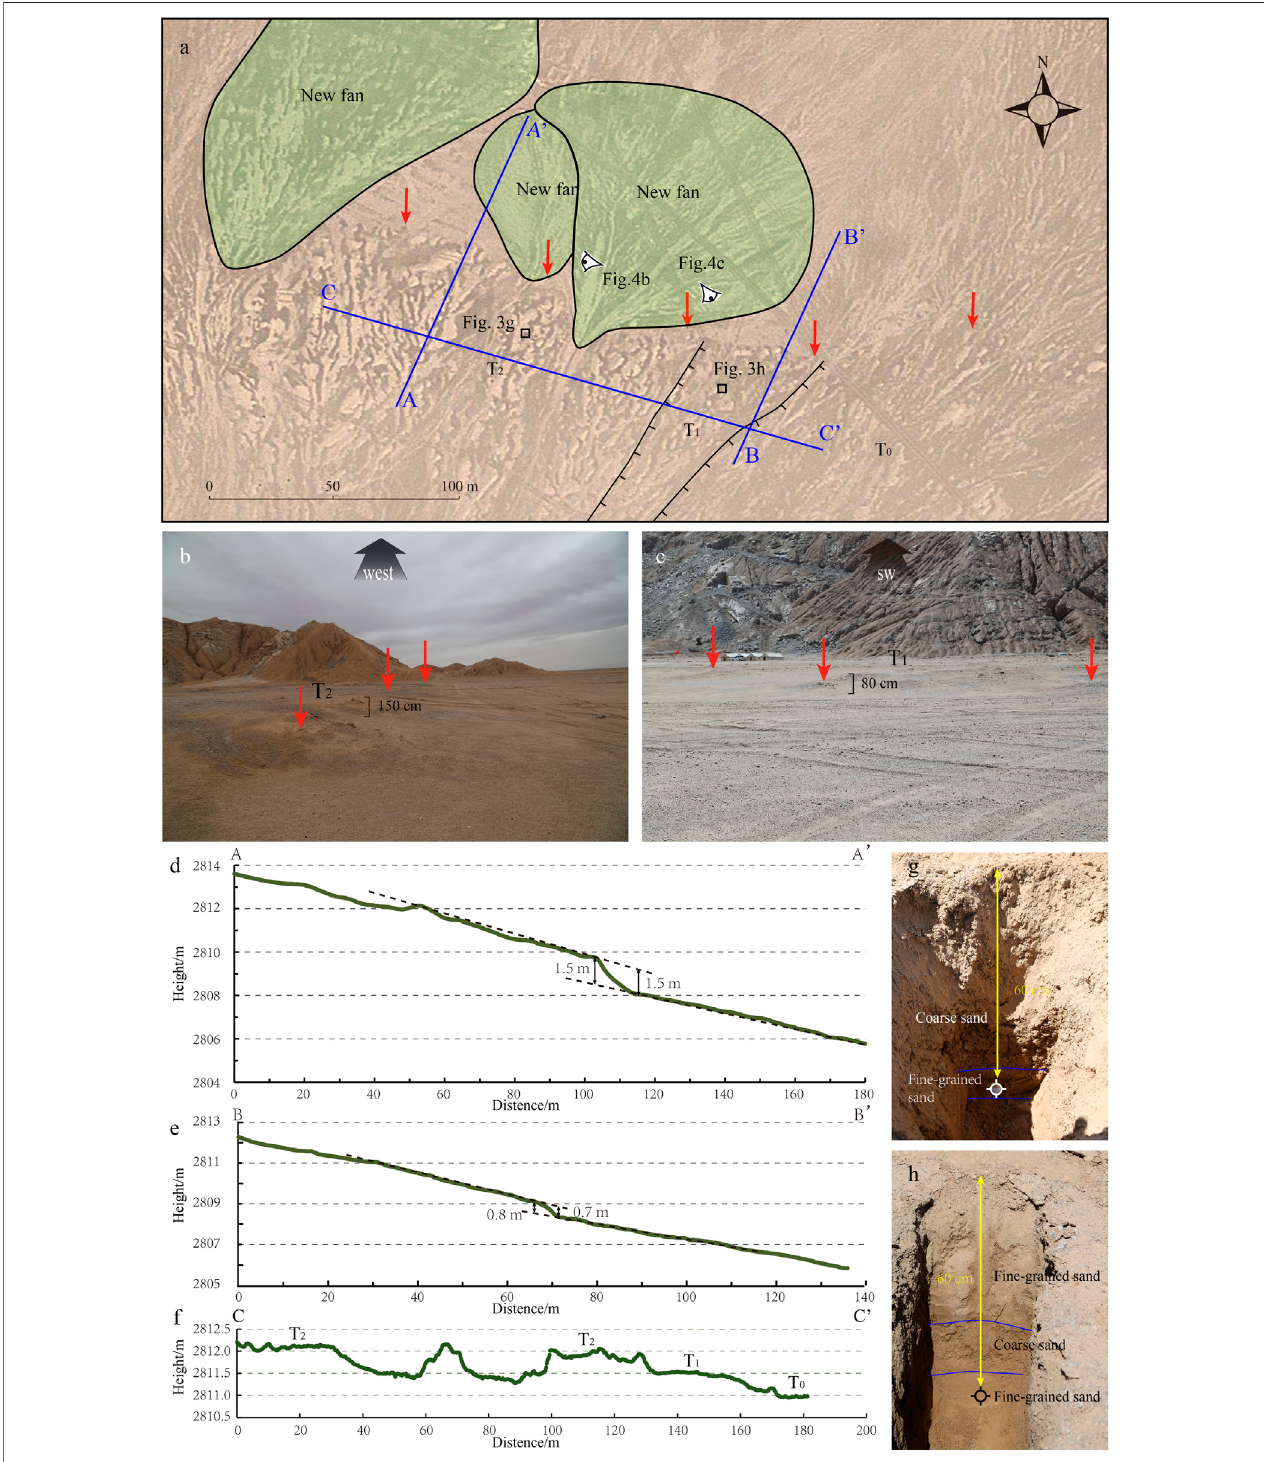
FIGURE 4 | (A) Google Earth image showing active trace of the SMQBF at the Xinlecun Site. Red arrows indicate conspicuous fault scarps. A-A ’ , B-B ’ and C-C ’ represent the location of topographic pro fi les in Figures 4D – F . The small black boxes indicate the location of samples. (B) and (C) Field photos of the scarps. (D,E) Topographicpro fi lesextracted fromDEMdatausedtomeasurethescarpheight. (F) Topographicpro fi lesacrossterrace risers. (G,H) OSLsamplingphoto. Samplesite is shown in Figure 4A .